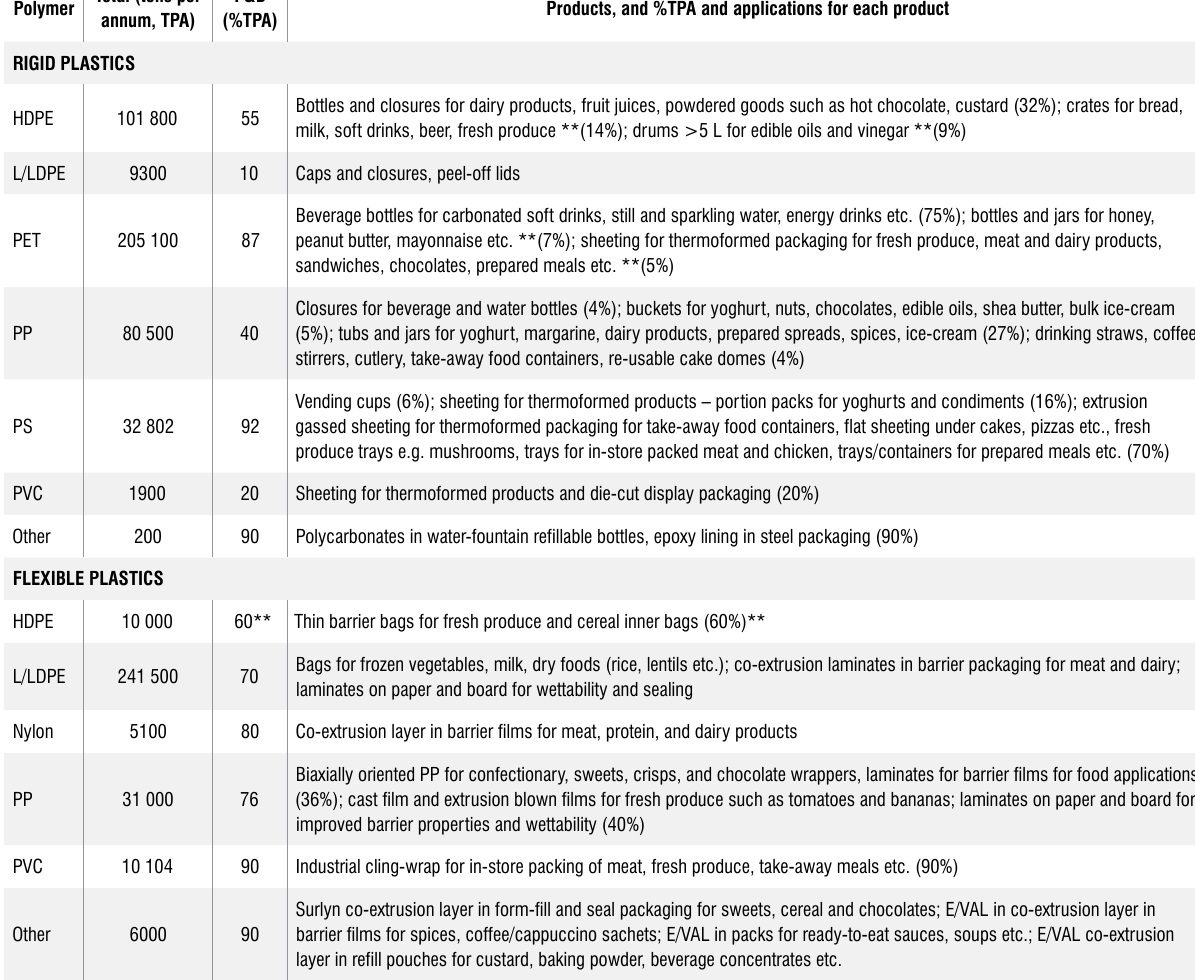
Table 1: Quantities, products and applications of plastics used by the food and beverage (F&B) industry in South Africa in 2019 Total (tons per F&B Polymer annum, TPA) (%TPA)